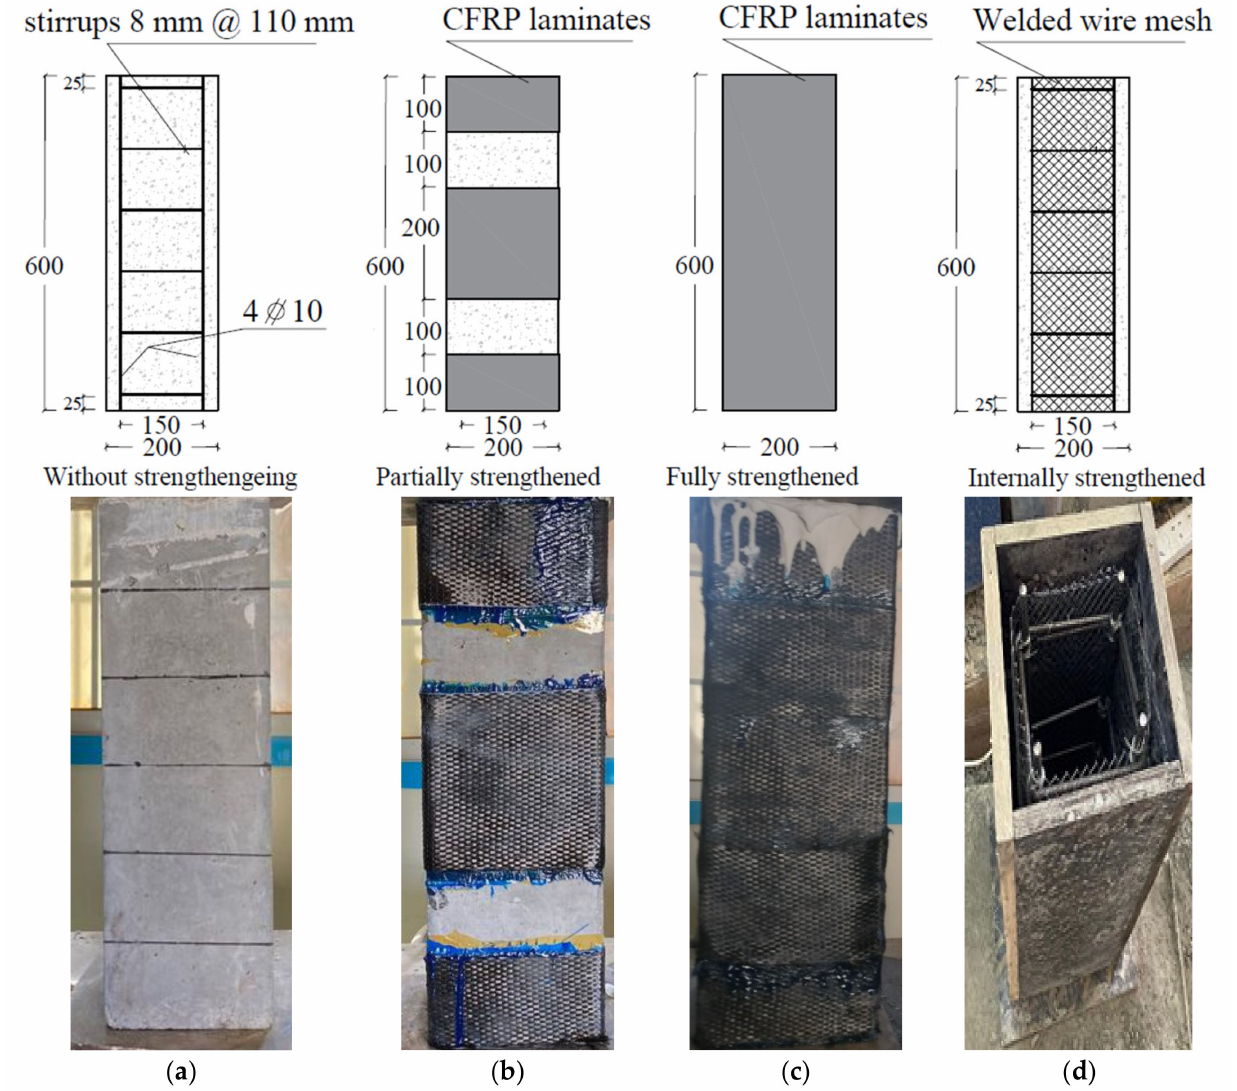
Figure 5. Details of the tested columns. ( a ) Control column, ( b ) partially EB CFRP, ( c ) fully EB CFRP, ( d ) welded wire